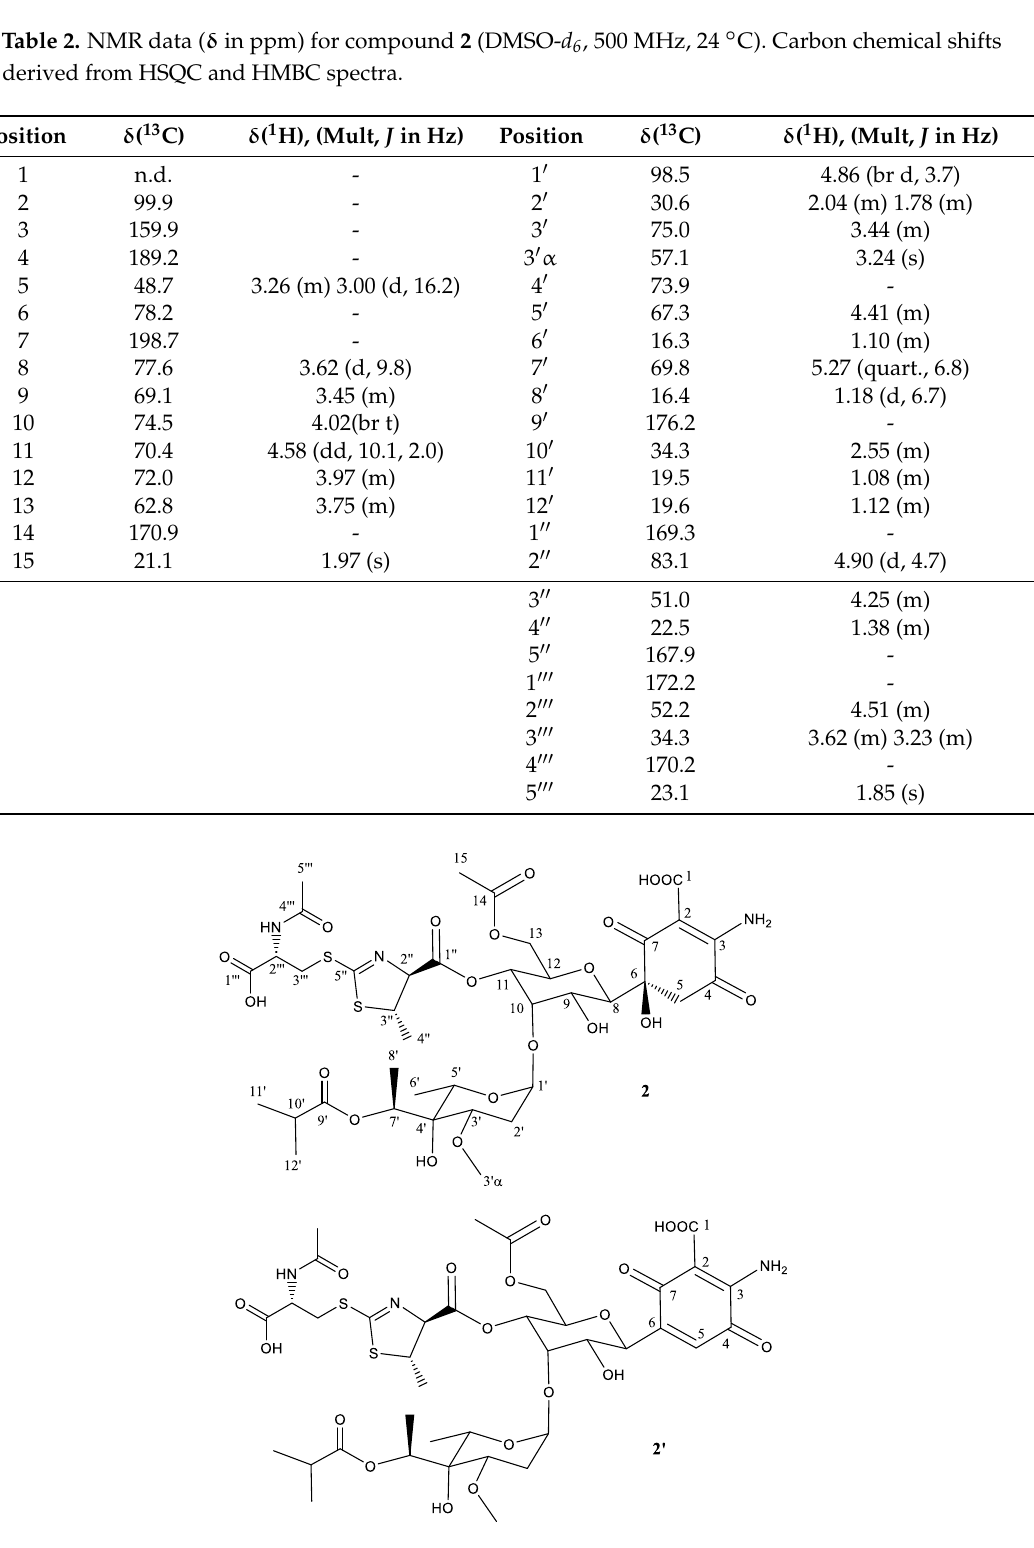
Figure 3. Structure of compound 2 deduced from 1 H- and 13 C-NMR data and proposed structure of secondary product compound 2 ′ after elimination of one molecule of H 2 O.